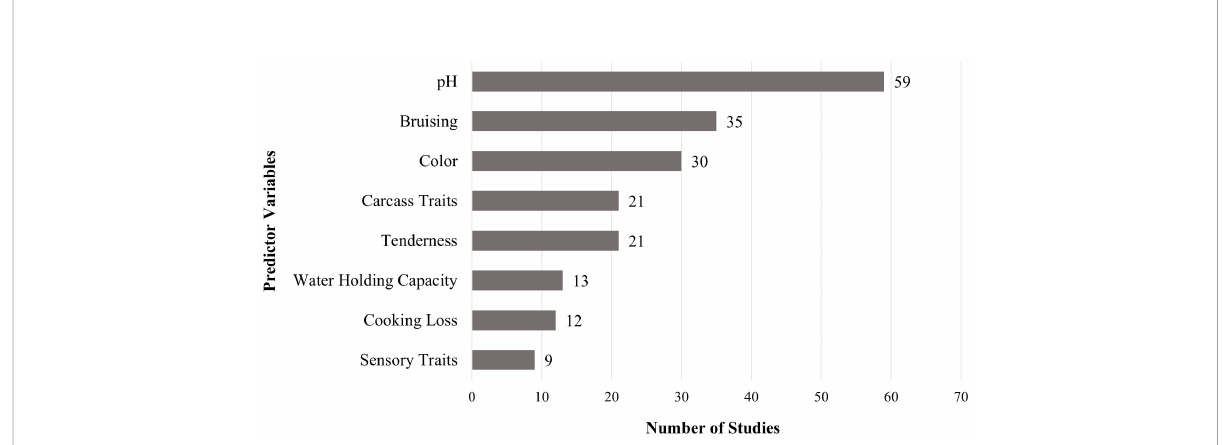
FIGURE 4 Number of studies that reported meat quality outcomes in response to pre-slaughter management factors ( n =85). Meat quality outcomes were categorized into eight overarching categories, including sensory traits, cooking loss, water holding capacity, tenderness, carcass traits, color, bruising, and pH. Some studies may have measured more than one